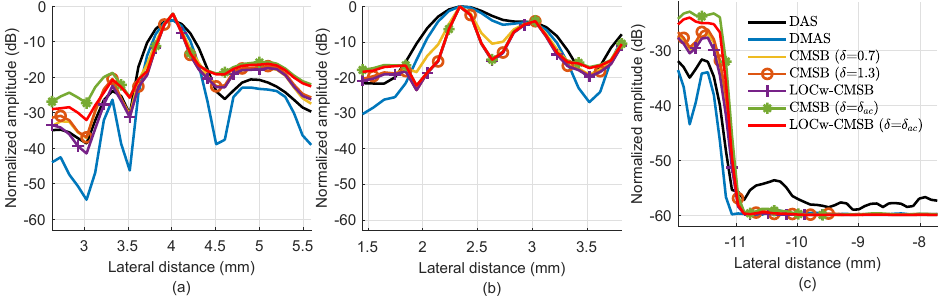
Figure 3. Lateral variations through point targets at the depth of ( a ) 23.1 mm and ( b ) 27 mm, and ( c ) the cyst target in simulated tissue-mimicking images. Table 2 lists image quality metrics of simulated tissue-mimicking images. Note that the resolution of the SLSC is not calculated because the image is not log-compressed. Compared with DAS, SLSC obtains a degradation of 9.1 dB in contrast, but it obtains the highest gCNR and sSNR. CMSB ( δ = 1.3) improves the resolution by 52.7% and 40.9% over DAS and DMAS, respectively. The proposed methods maintain the resolution performance of CMSB ( δ = 1.3). In addition, LOCw-CMSB improves the CR by 5.8% and 14.7% compared to CMSB ( δ = 0.7) and CMSB ( δ = 1.3), respectively, whereas the gCNR and sSNR are slightly higher than that of CMSB ( δ = 0.7). The gCNR and sSNR obtained by CMSB ( δ = δ ac ) are 4.3% and 40.6% larger than that of CMSB ( δ = 1.3), whereas CR decreases by 2.0%. Furthermore, LOCw-CMSB ( δ = δ ac ) leads to improvements of 12.4%, 4.3%, and 36.6% in CR, gCNR, and sSNR over CMSB ( δ =